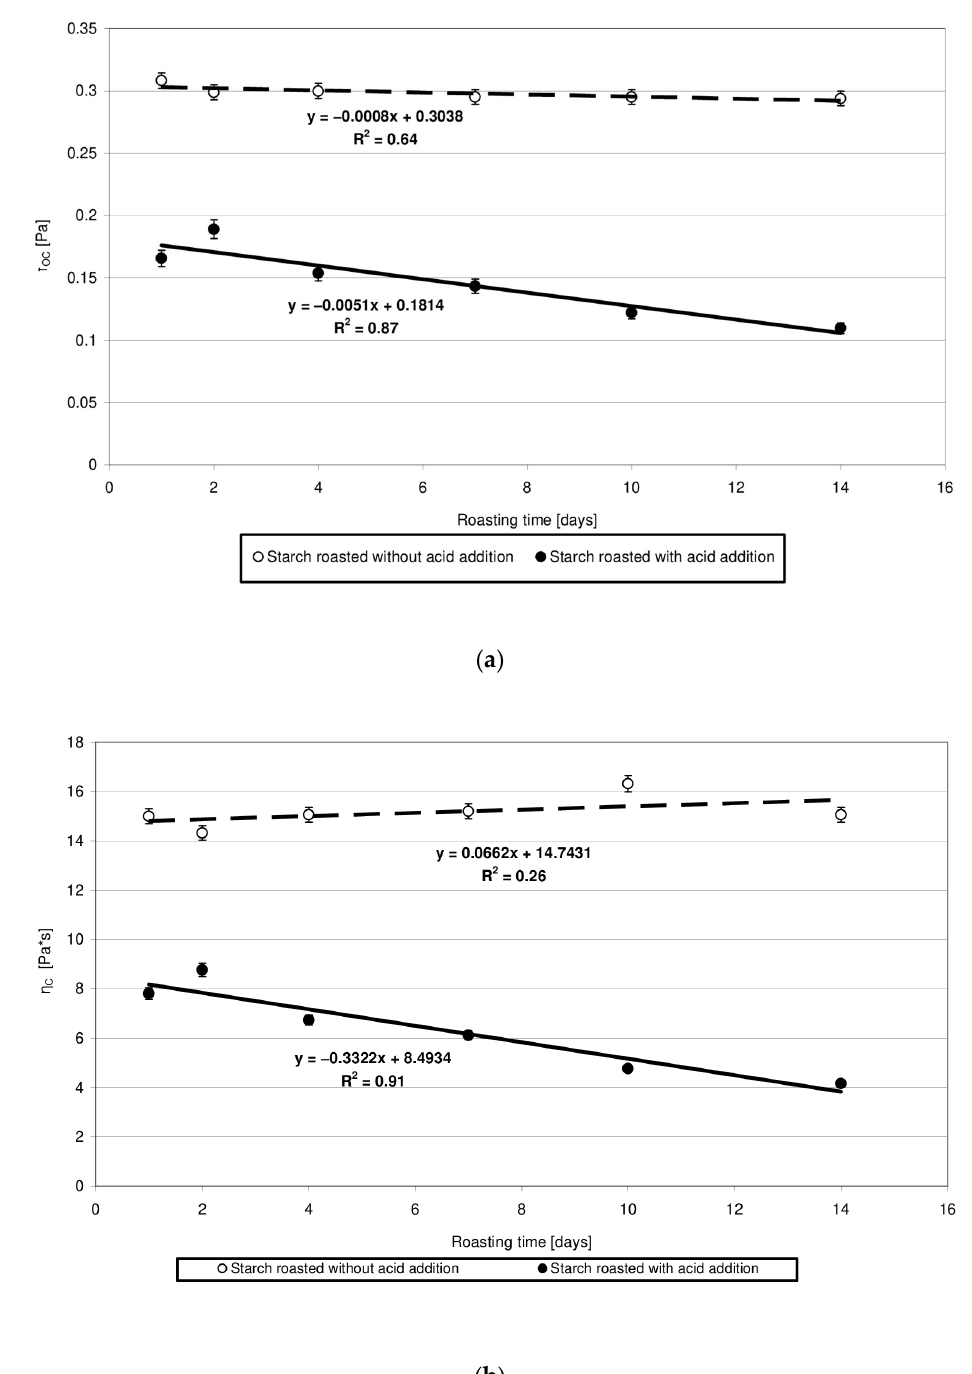
Figure 7. ( a ) Dependency of the Casson’s coefficient ( τ oc ) on the time of starch retention with and without citric acid. ( b ) Dependency of the Casson’s plastic viscosity ( η C ) on the time of starch retention with and without citric acid.